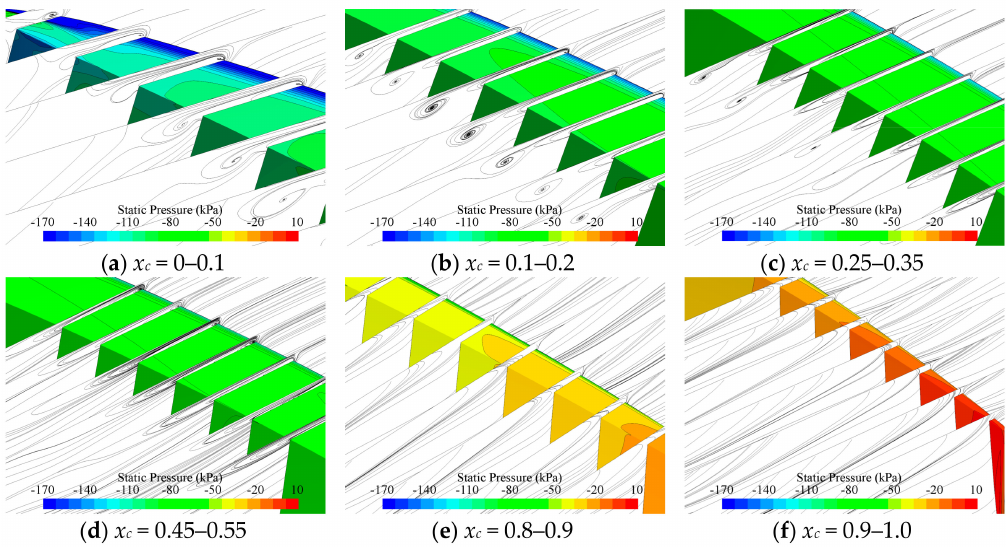
Figure 13. The streamlines (colored by static pressures) in sections across the tip surface, where x c is the chordwise distance from the leading edge in fractions of the chord length. Q = 0.42 m 3 /s.